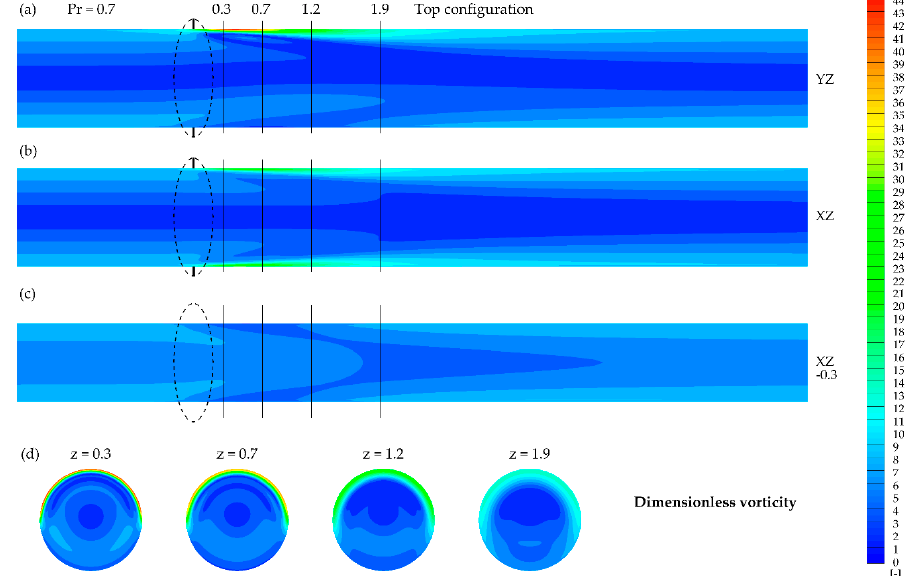
Figure 14. Dimensionless vorticity contours obtained for Pr = 0.7 and top configuration in the presence of the magnetic field at: ( a ) YZ plane, ( b ) XZ plane, ( c ) XZ plane ( y = − 0.3), ( d ) XY planes at given z .